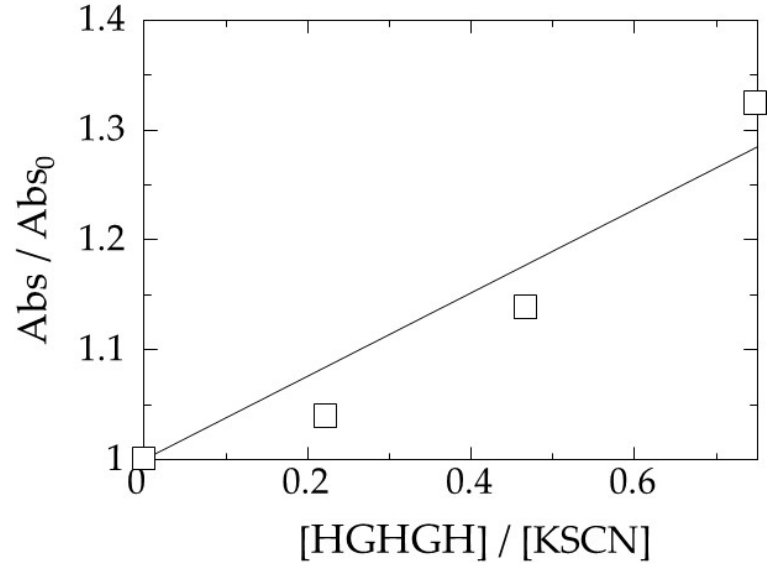
Figure 5. The 500 nm absorbance of 1 mmol L − 1 KSCN solution (Abs 0 ) compared to aqueous solutions of HGHGH mixed with KSCN (Abs) as a function of the H5 and KSCN ratio. The rate constant of H5 with OH was calculated as 4.2 × 10 9 mol − 1 L s − 1 , based on Equation